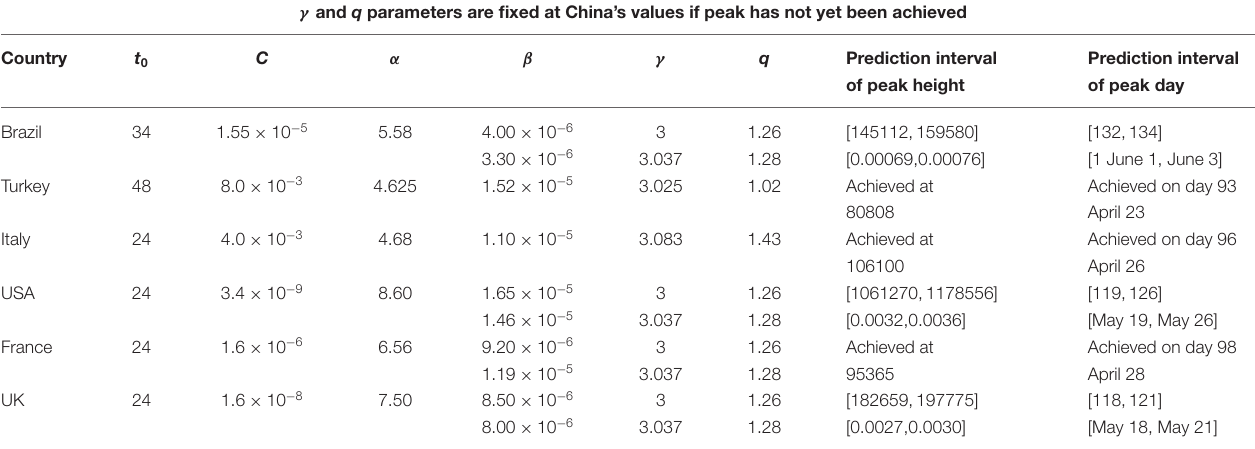
The second line in the column for the prediction interval of the peak height of active cases shows the same values divided by the total population of the country.